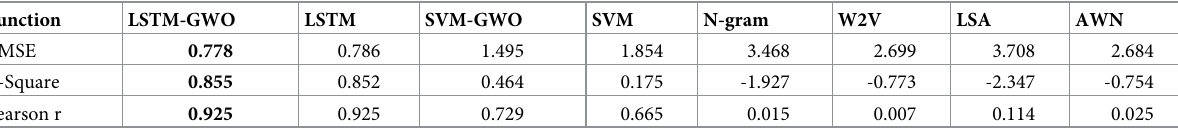
Table 12. Comparison of the proposed model and compared models with experiment 8.